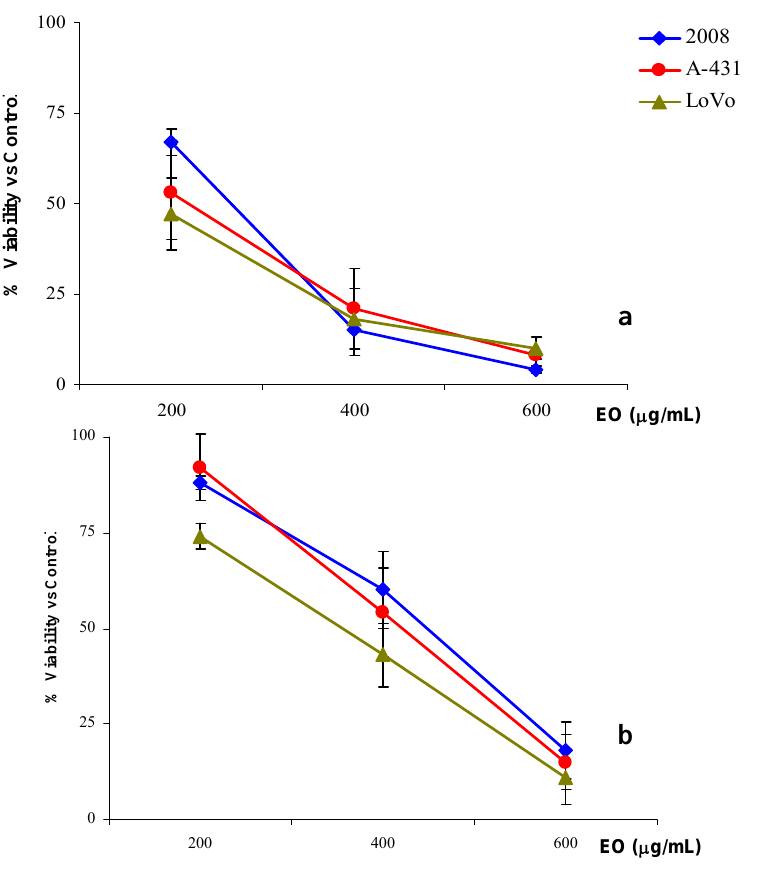
Figure 1. % cell viability versus control of 2008, LoVo and A-31 cells treated with R. anthopogon essential oil (EO) for 3h + 21h incubation in culture medium (a) or 24h